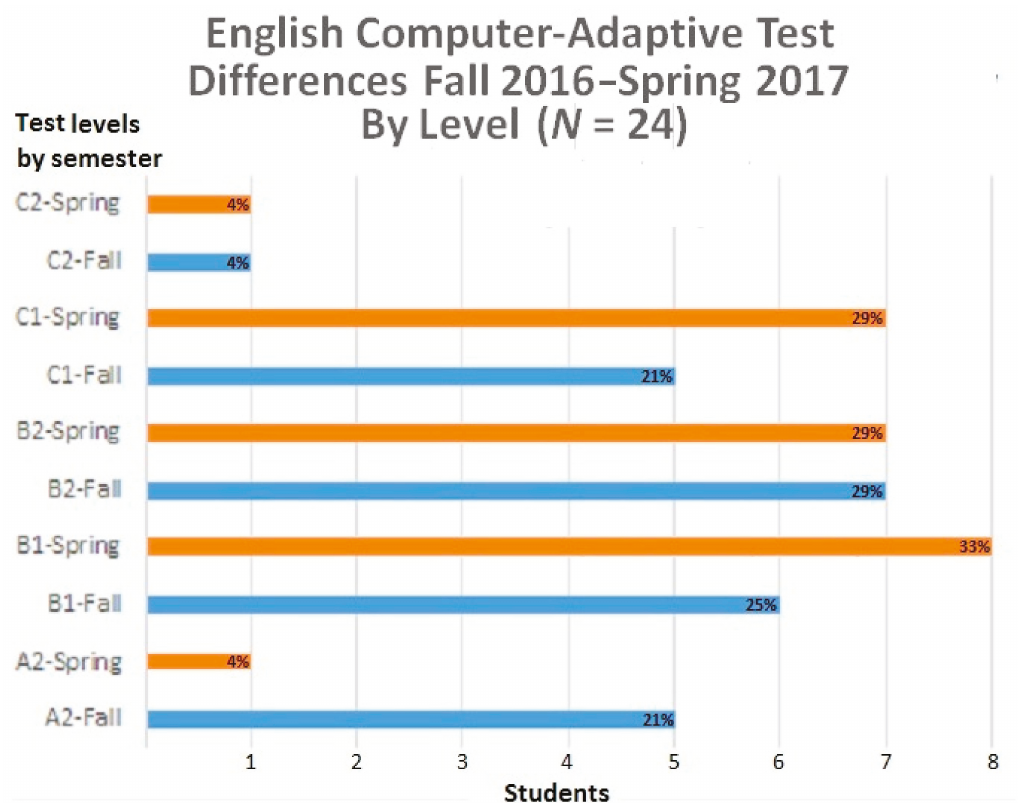
Figure 4. Fall 2016–Spring 2017 E-CAT